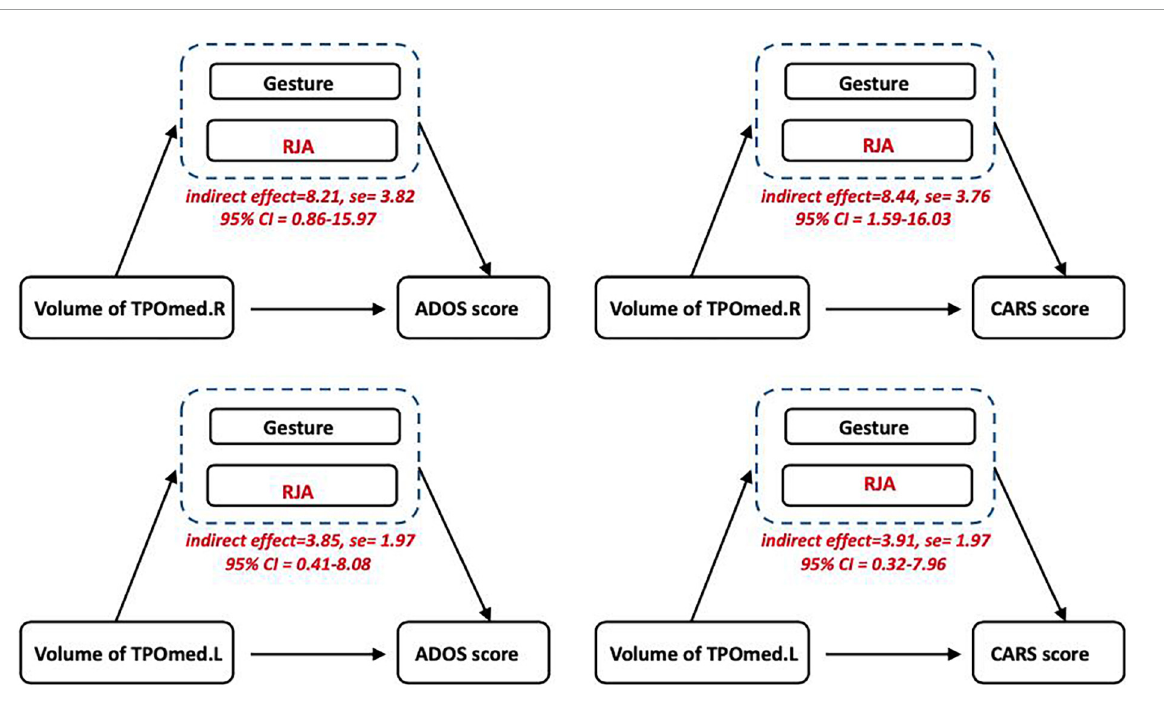
TABLE 3 Comparison of gray matter volume (GMV) between autism spectrum disorder (ASD) patients with and without developmental delay (DD). Region Cluster size (voxels) Peak t value Peak MNI Temporal_Pole_Mid_L(TPOmed.L)/Temporal_Inf_L 744 4.56 Temporal_Pole_Mid_R (TPOmed.R) 608